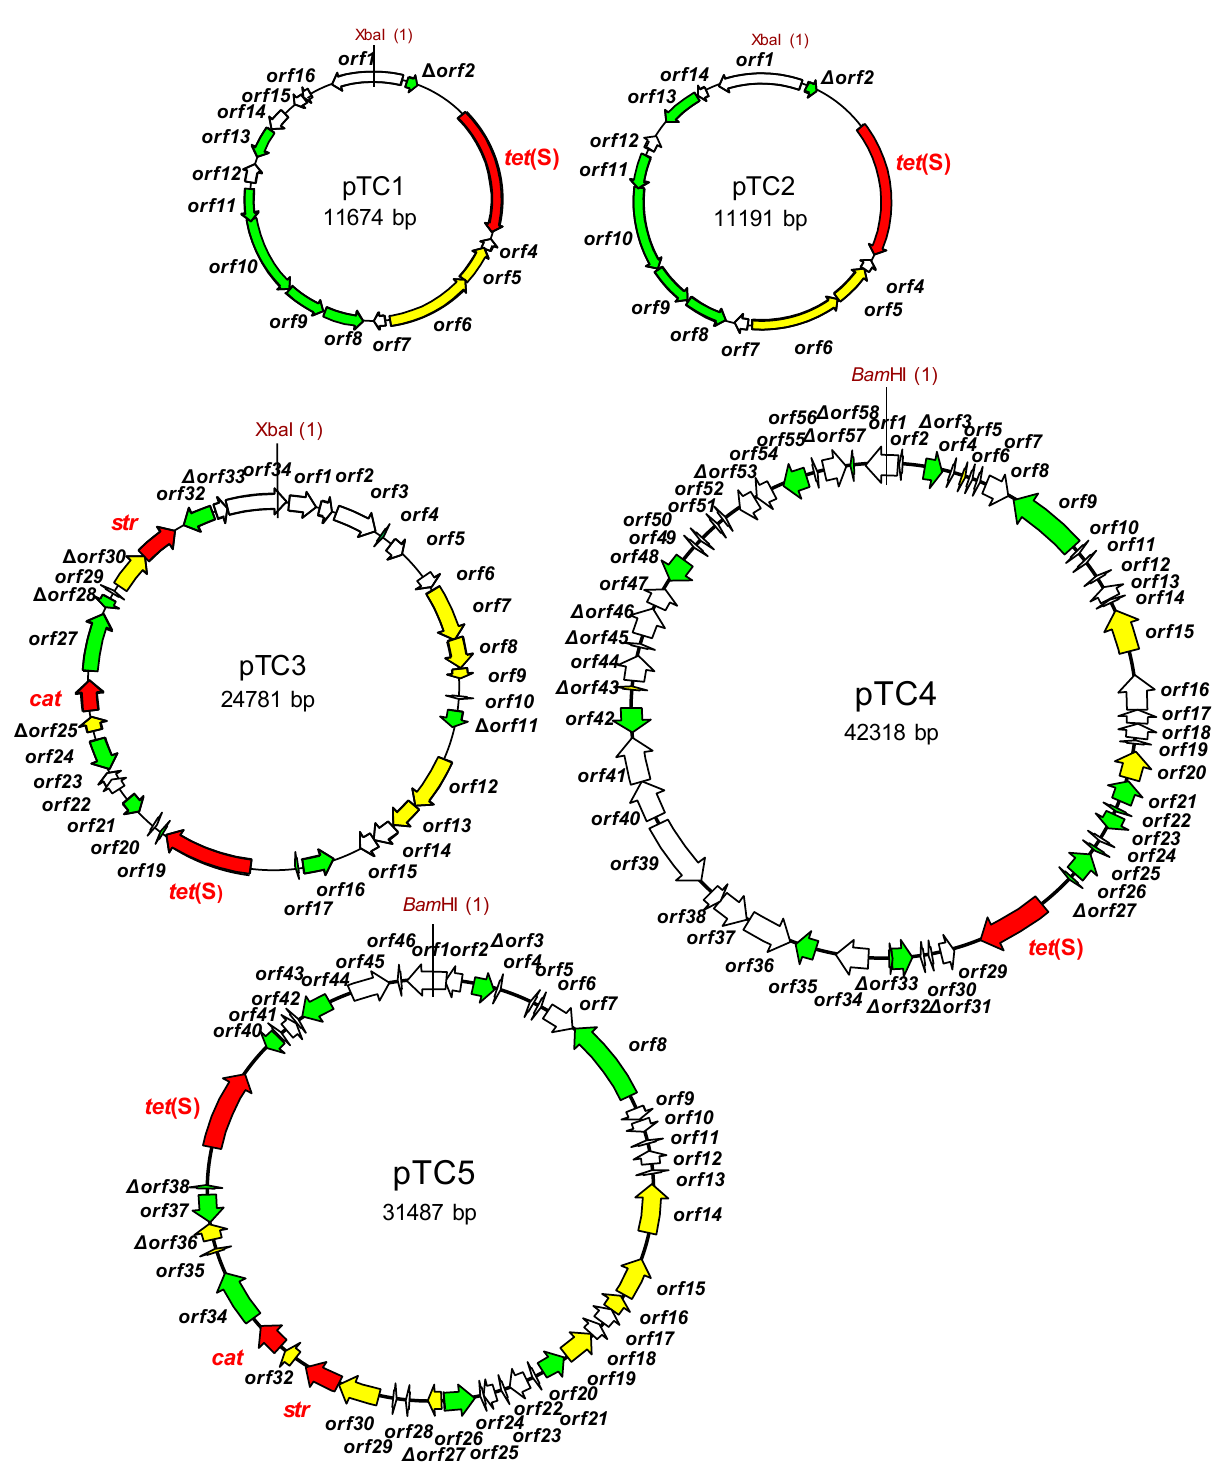
Figure 2. Drawn to scale genetic maps of the tetracycline resistance plasmids recovered in Lactococcus lactis , pTC1 through pTC5. Arrows indicate the position, direction and length of the open reading frames (ORFs) identified. The position of tet (S), str and cat genes are highlighted in red. Color code of the ORFs: red, antibiotic resistance genes; yellow, genes involved in replication; green, insertion sequences and genes involved in mobilization; white, genes encoding other or unknown functions.